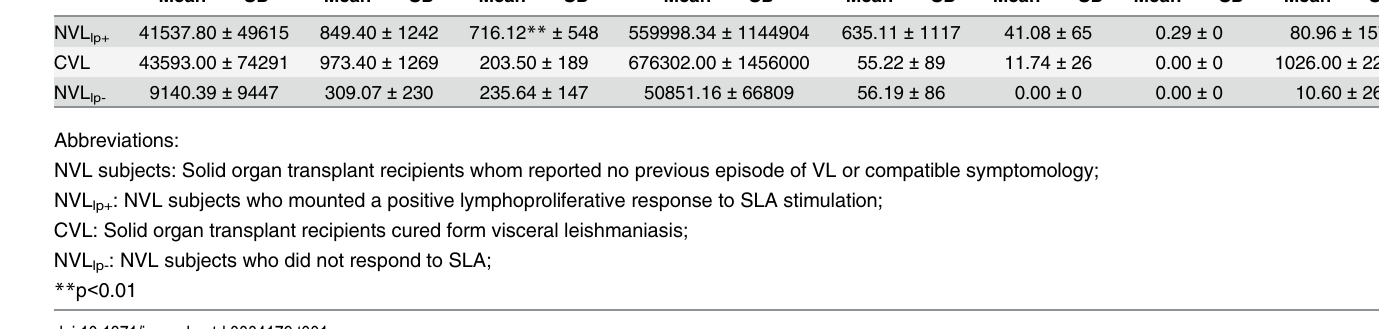
Table 1. Cytokine and granzyme B production after PBMC stimulation with PHAM for 5 days. IFN- γ , granzyme B, TNF- α , IL-10, IL-5, IL-17A, IL-2 and IL-4 concentrations (pg/ml) were measured in culture supernatants of 12 NVL lp+ subjects, 7 NVL lp- subjects, and 5 CVL subjects.